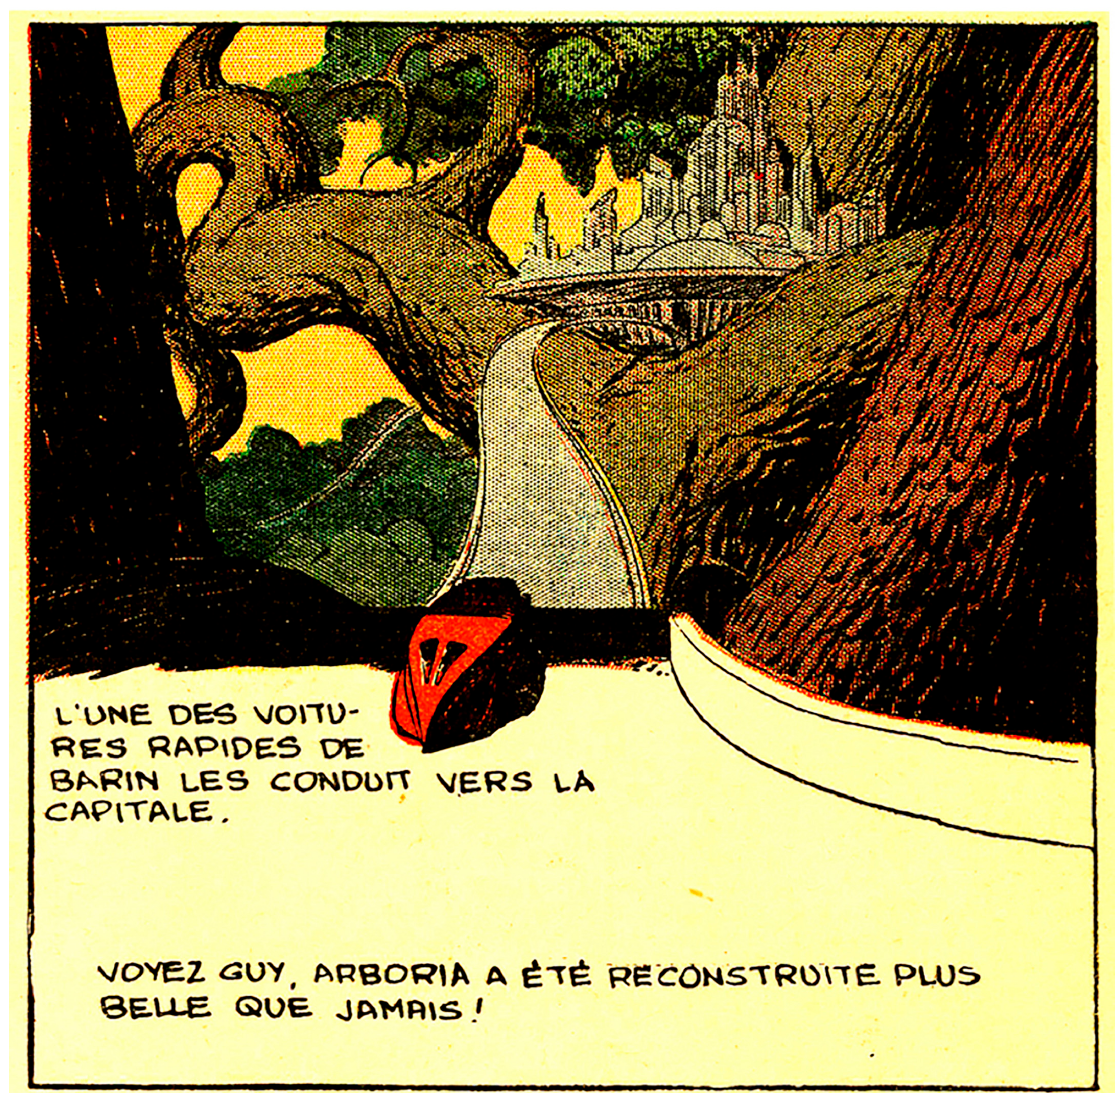
Figure 5. Alex Raymond, Flash Gordon,